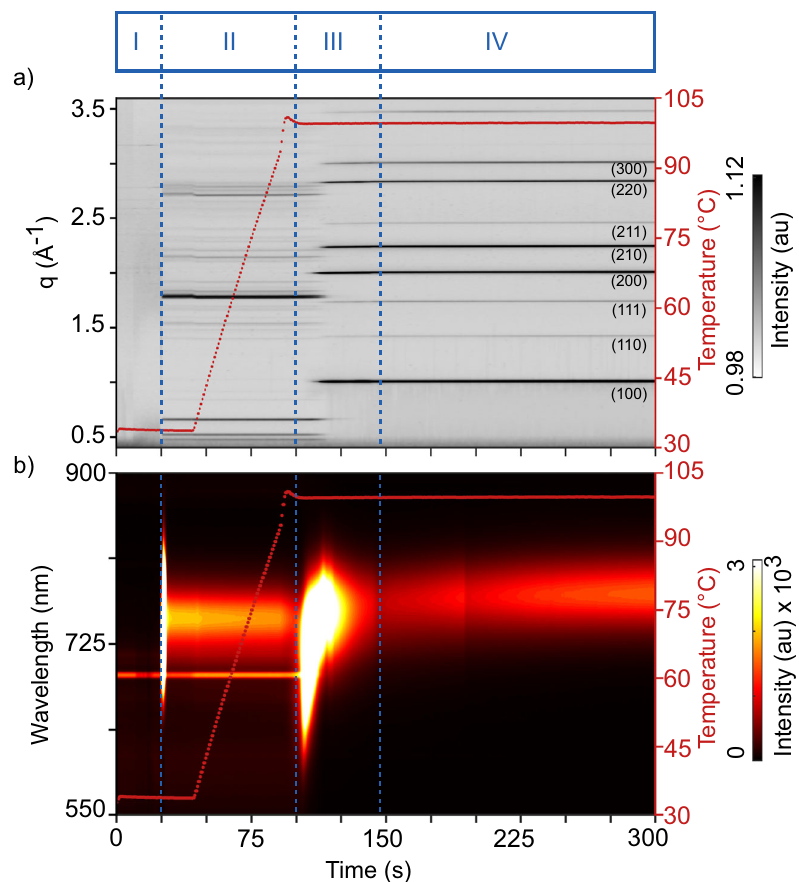
Fig. 1 Mapping with four phases seen in GIWAXS and PL data. Time evolution representing the four phases of the colloidal conversion process of PbI 2 .CH 3 NH 3 I.DMSO.DMF precursor to a fi nal crystalline MAPI thin fi lm as indicated by vertical dotted lines. a Radially integrated GIWAXS data as a function of q position and ( b ) PL data as a function of wavelength together with the substrate temperature (right y-axis). The narrow line emission at 690 nm is related to the diffuse re fl ection of the laser used in the position alignment system of the beamline. Phase I shows the spin coating followed by the antisolvent drop at t = 25 s. In phase II, we observe diffraction from Pb 3 I 8 .2(CH 3 ) 2 SO.2CH 3 NH 3 (MAPI·DMSO) solvent-complex phase, which is converted into MAPI crystals in phase III during annealing.